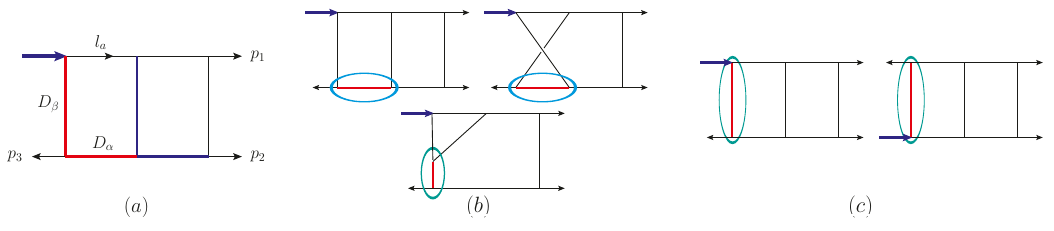
Figure 15. Examples of generalized gauge transformations of tr( φ 2 ) form factors. The momenta labelling is shown in figure (a). (b) and (c) are two types of generalized gauge transformations involved in the cancellation of free parameter c 1